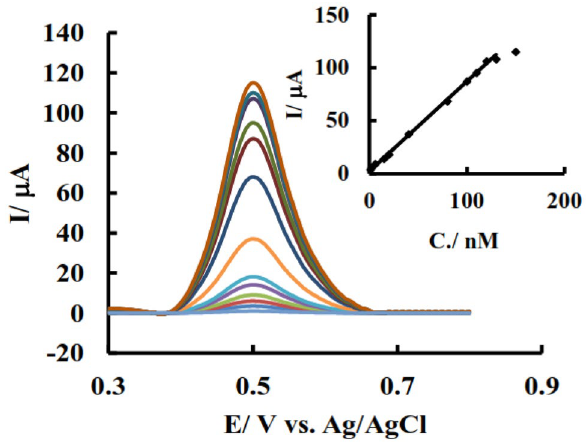
Figure 7. SWV of N, S-GQD in 0.5 M KNO 3 after addition different concentrations of Fe(III); inset: Variation of current versus concentration related to above voltammograms.